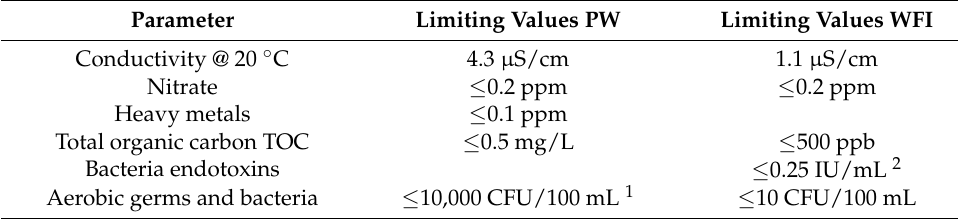
Table 1. Limiting values for PW and WFI